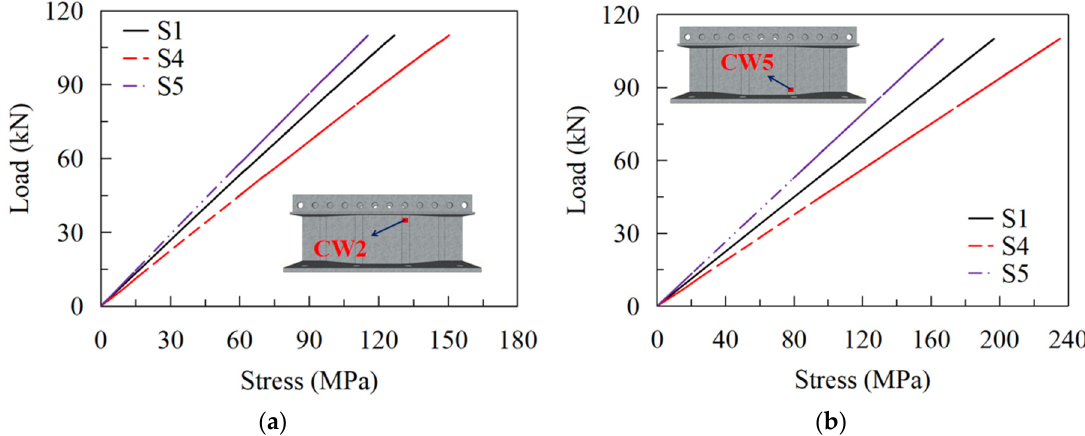
Figure 22. Load-stress curves for models with different web thicknesses: ( a ) CW2; ( b ) CW5.